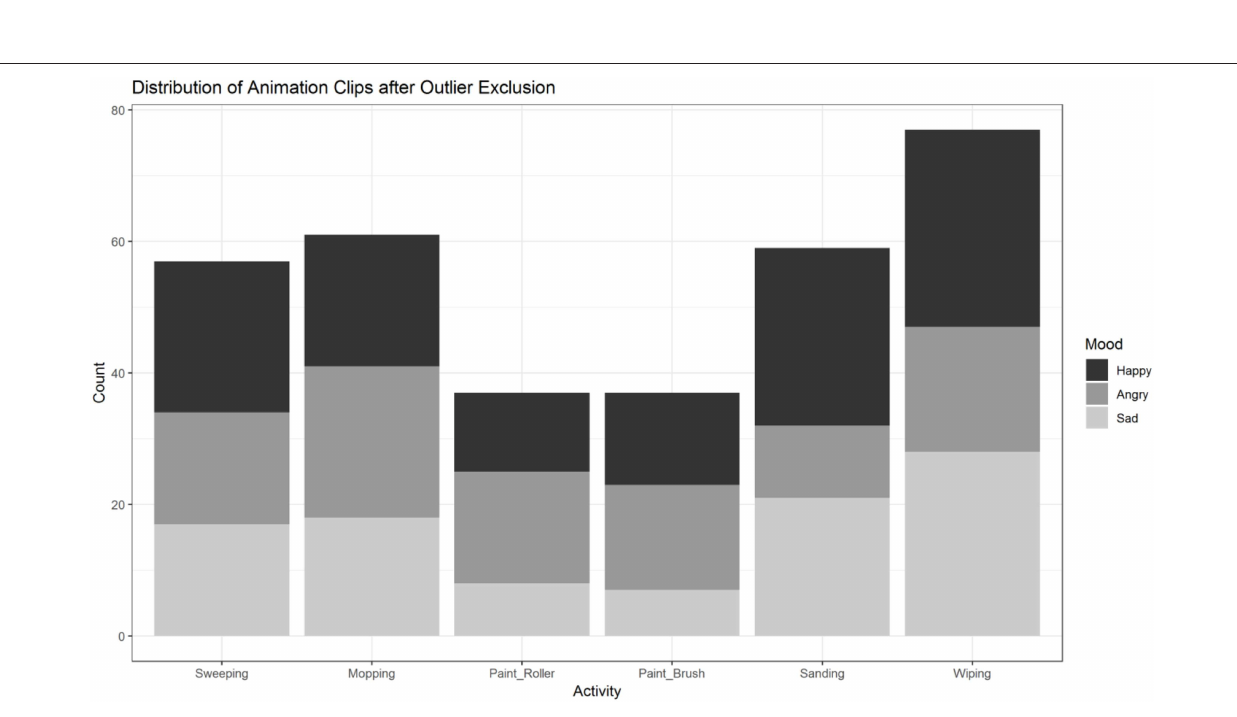
FIGURE 9 | Distribution of animation clips ( n = 328) across activities and moods after exclusion of outliers based on low-level feature extraction. Painting-activities were excluded significantly more often than the four other activities. The distribution of sanding and wiping across moods is unbalanced compared to sweeping and